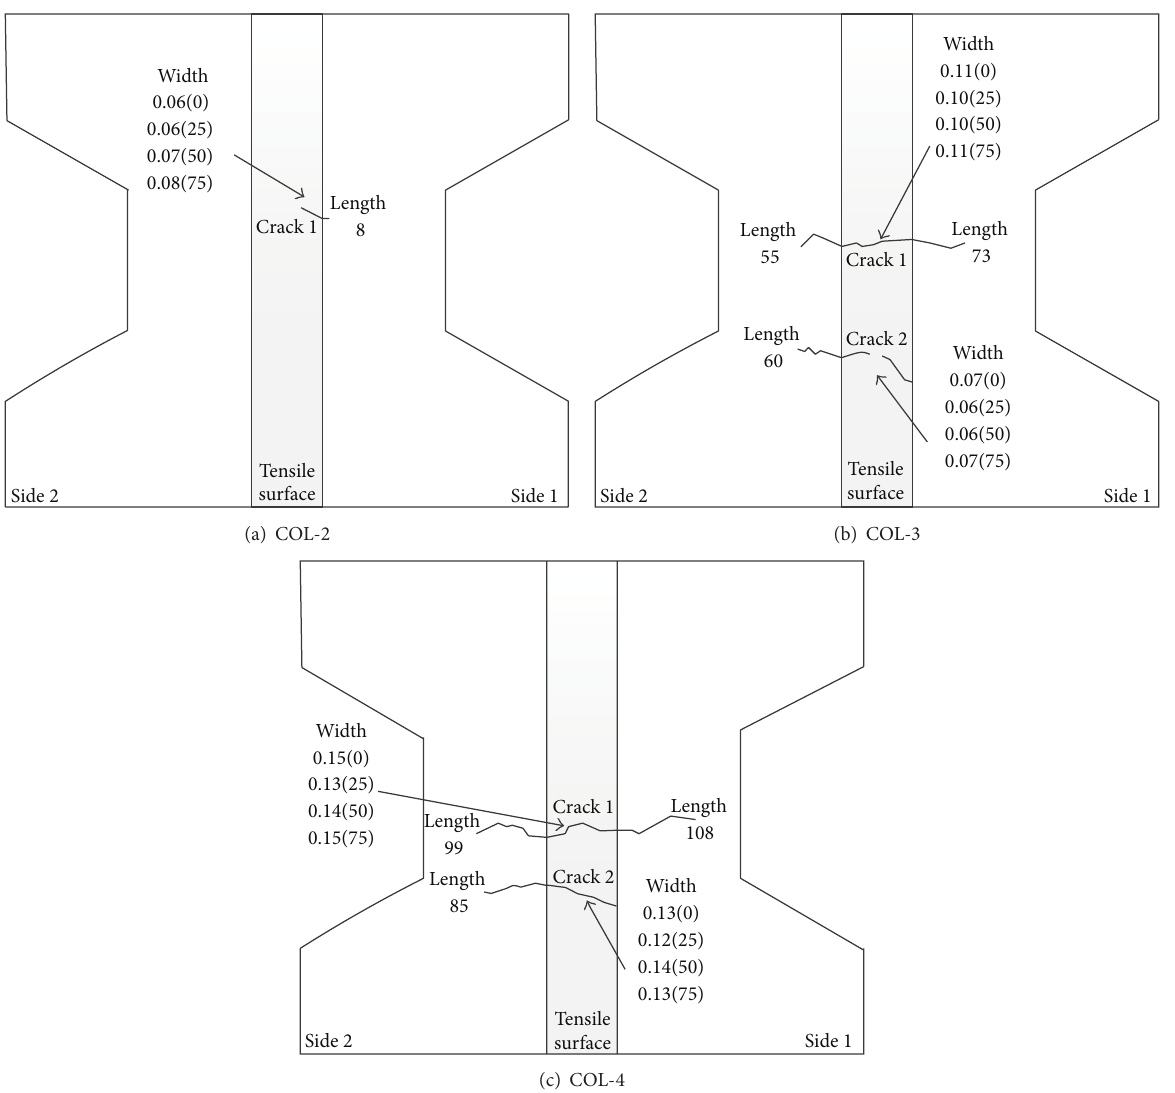
was applied to column specimens COL-2 ∼ COL-4 to induce and maintain cracks. As expected, the cracks were